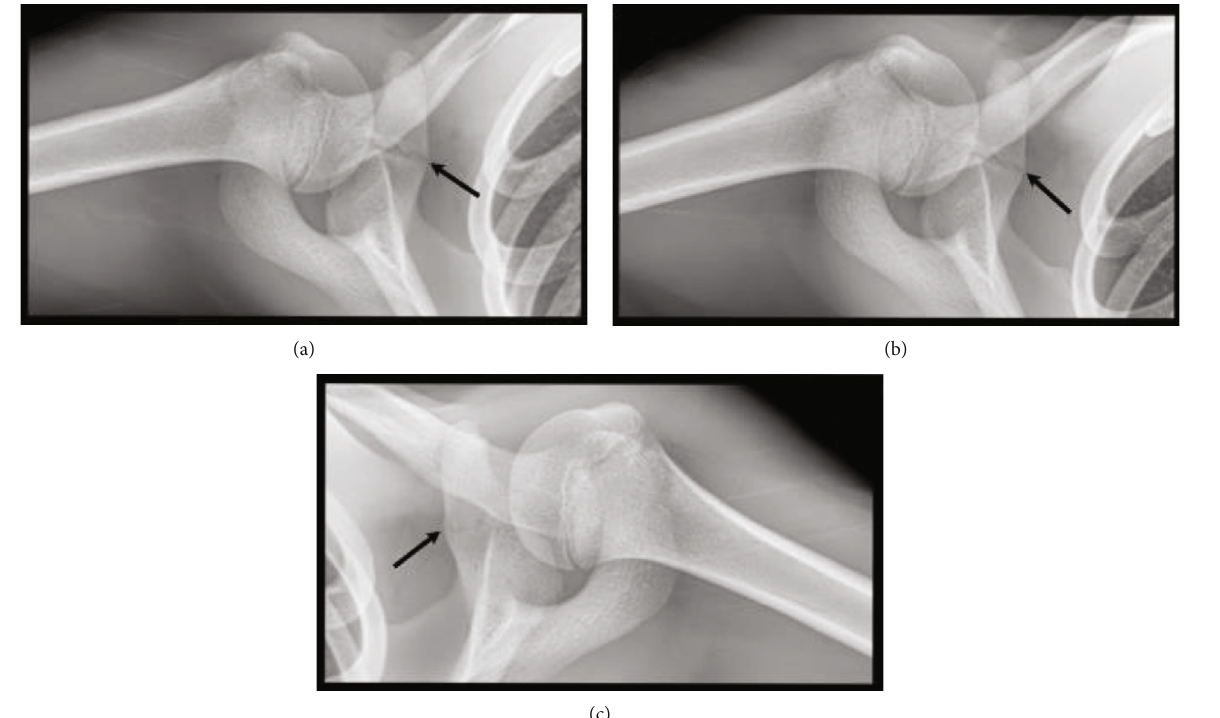
Figure 1: (a) Radiograph of injured shoulder taken at fi rst clinical visit (12/27/2018) (7.5 weeks after the injury). (b) Radiograph of injured shoulder taken at the second clinical visit (1/31/2019) (approximately 11 weeks after the index injury). Note that the lucency extends across the entire coracoid. (c) Radiograph of contralateral (noninjured) shoulder taken at second clinical visit. Note that the lucency at the medial aspect of the coracoid is much less obvious when compared to the injured side.